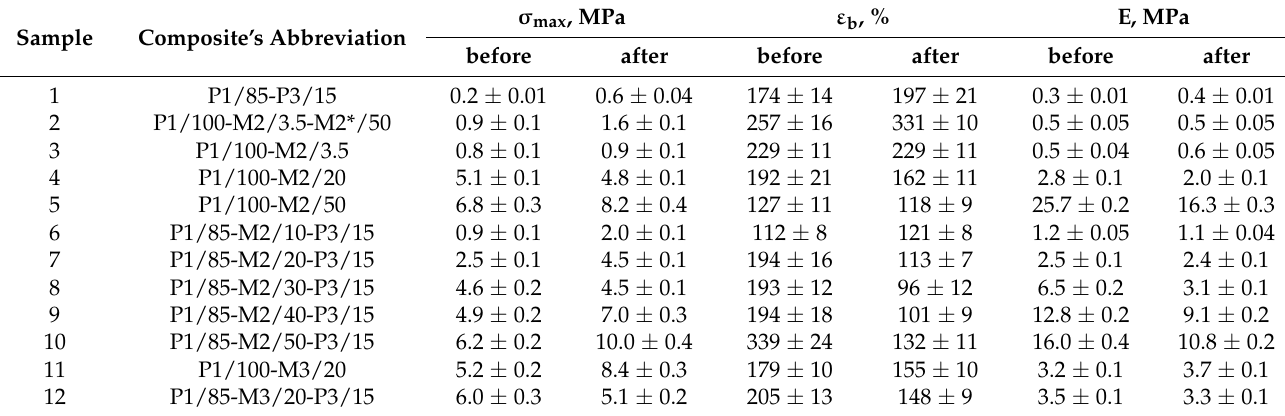
Figure 2. Deformation curves of molecular composites before and after HT: ( a ) Composites based on P1 containing P3 , filled with 16,67 wt.% (Sample 7) or 33,33 wt.% (Sample 10) M2 and without (Sample 1) M2 ; ( b ) Composites based on P2 containing P3 , filled with 16,67 wt.% (Sample 16) or 50,00 wt.% (Sample 21) M2 and without (Sample 13) M2 ; ( c ) Composites based on P1 not containing P3 , filled with 16,67 wt.% ( Sample 4) or 33,33 wt.% (Sample 2) M2 ; ( d ) Composites based on P2 not containing (Sample 14) or containing (Sample 19) P3 , filled with 33,33 wt.% M2 ; ( e ) Composites based on P1 not containing (Sample 11) or containing (Sample 12) P3 , filled with 16,67 wt.% M3 . Table 2. Mechanical properties of P1 -based composites before and after